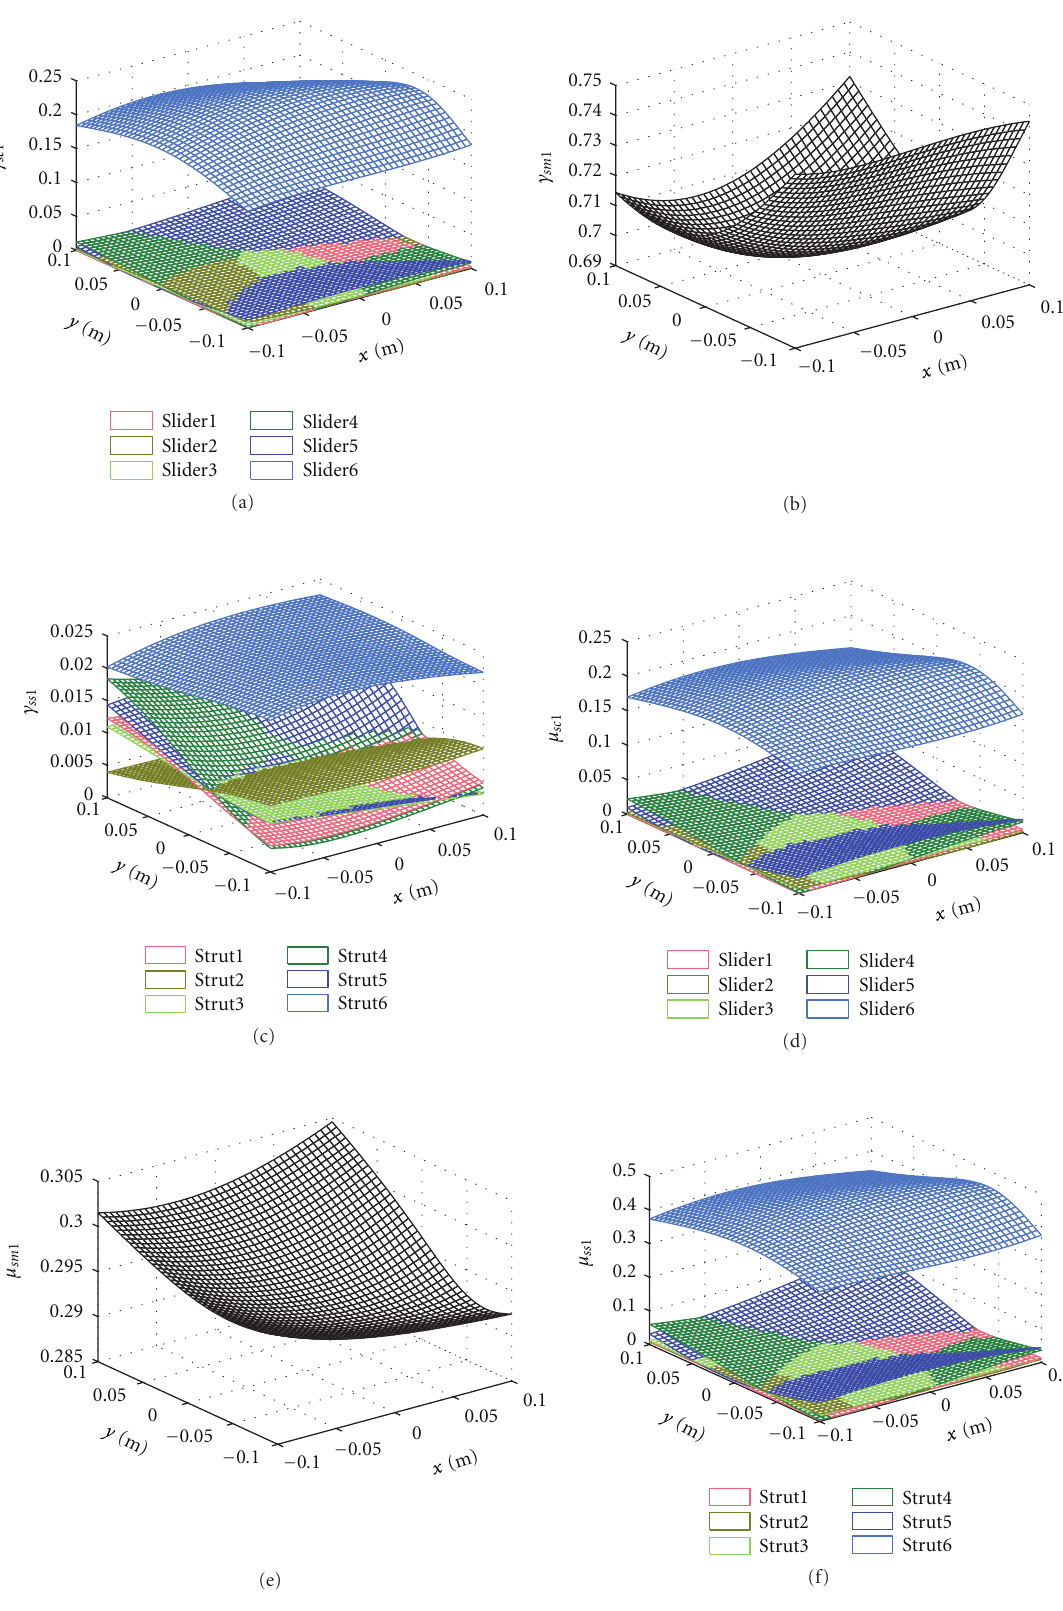
Figure 7: Distributions of the energy ratios in the workspace. (a) Kinetic energy ratios of the sliders. (b) Kinetic energy ratio of the moving platform. (c) Kinetic energy ratios of the struts. (d) Elastic potential energy ratios of the sliders. (e) Elastic potential energy ratio of the moving platform. (f) Elastic potential energy ratios of the